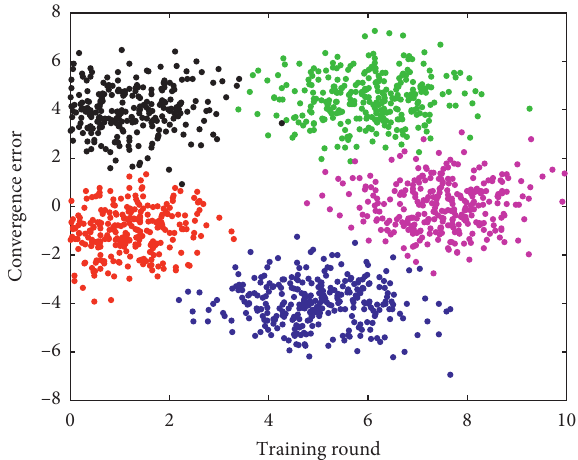
Figure 8: The convergence of the virtual system after optimization.